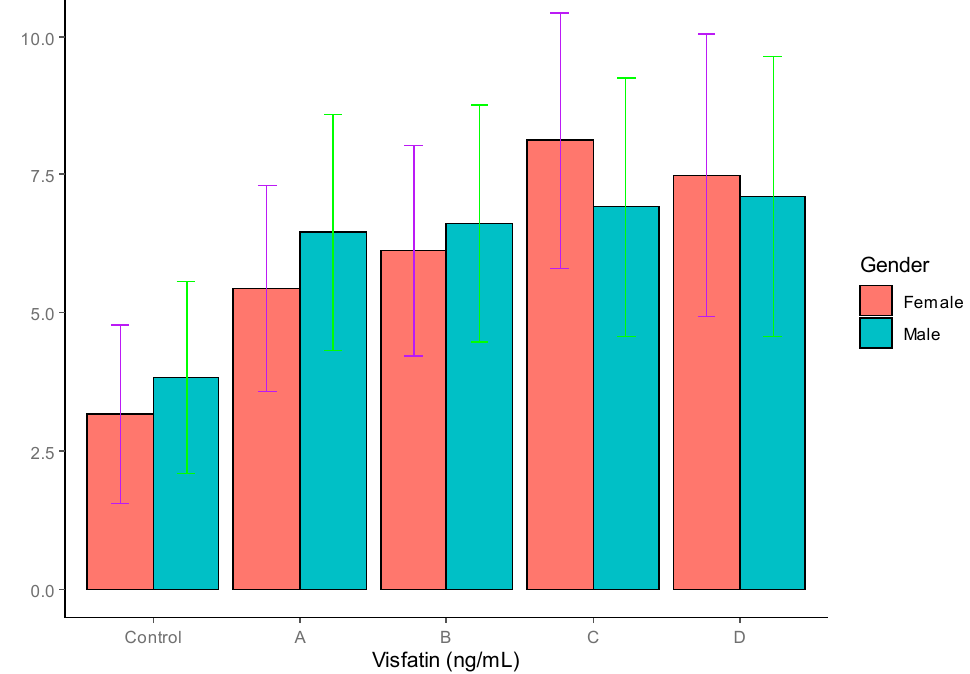
Figure 4. Serum visfatin levels in T2DM patients and control groups (ng/mL).